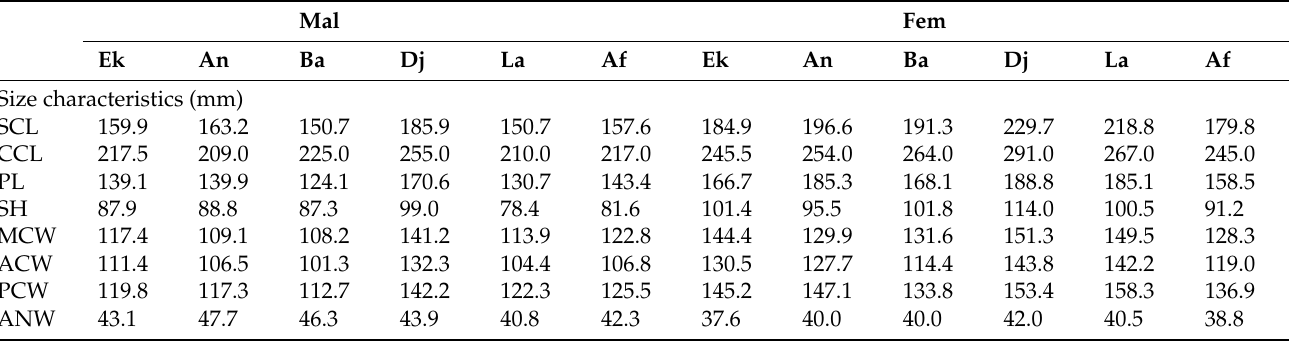
Table A4. Body size maximum measurements among adults of Algerian T. graeca populations. Abbre- viated characteristics are explained in the Materials and Methods section. Mal—males; Fem—females. Maximum values among the six populations are in